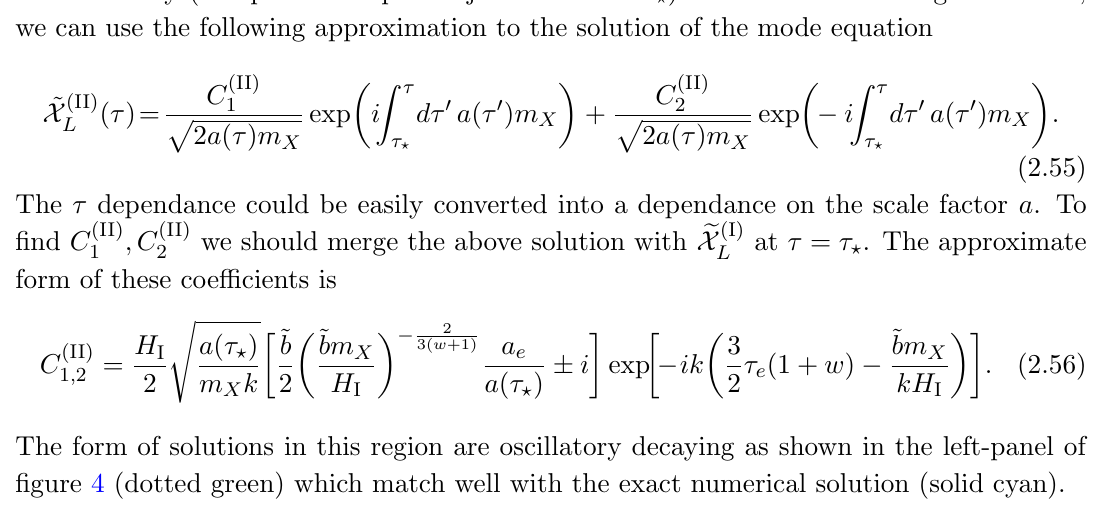
Figure 4 . Evolution of the mode function j e X L j 2 (upper) and frequency ! 2 factor a after in(cid:13)ation for k < k m (left-panel), k m < k < k ? (middle panel), and k ? < k < k e (right- panel). The solid cyan curves correspond to the exact numerical solution, while colored dashed lines show analytical predictions. Here we take m X = 10 8 GeV, H I = 10 13 GeV, w = 0 with k = 10 (cid:0) 8 GeV ; 10 (cid:0) 3 GeV ; 1 GeV for the left, center, and right plots,